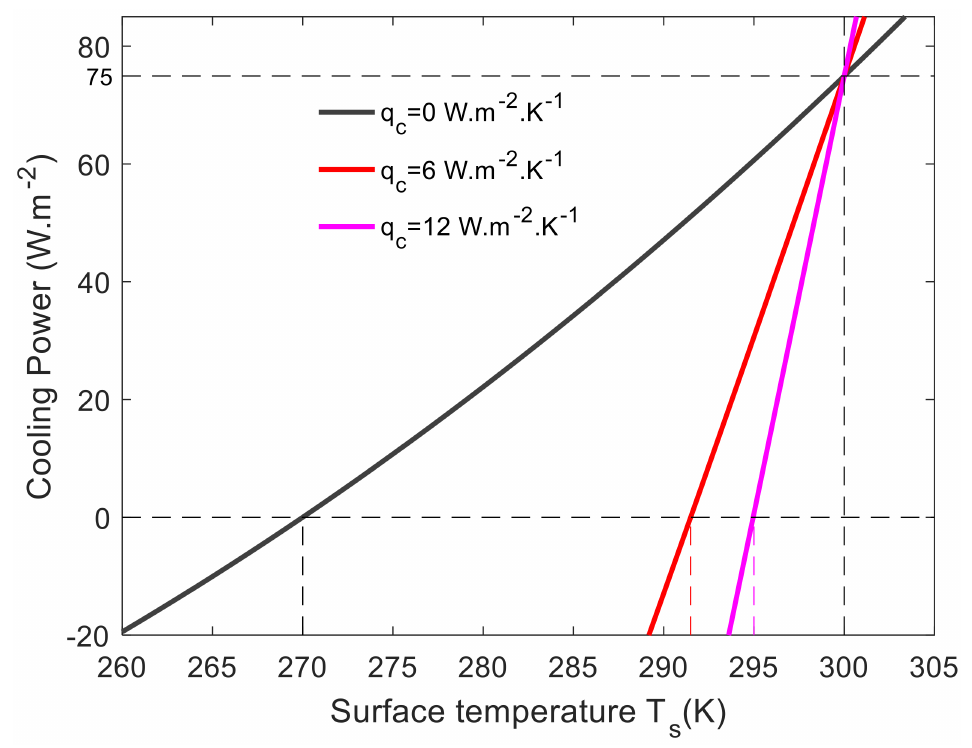
Figure 10. Calculated net daytime cooling performance the proposed cooler design versus radiative cooler temperature with different thermal coefficients q c = 0, q c = 6 and q c = 12 W/m 2 · K.